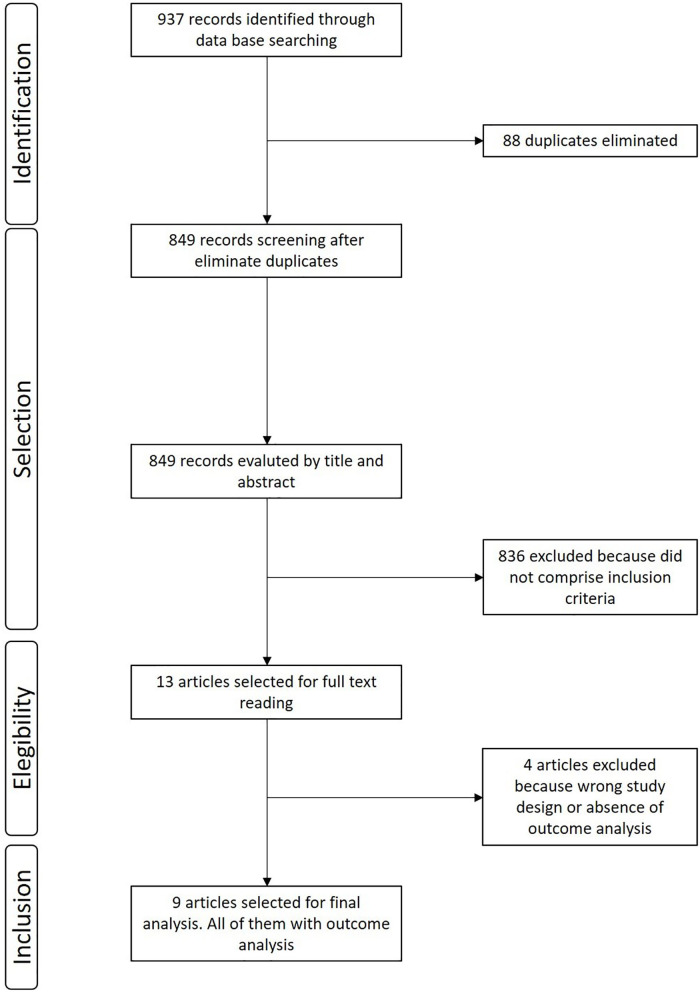
Flow diagram of the selection process.